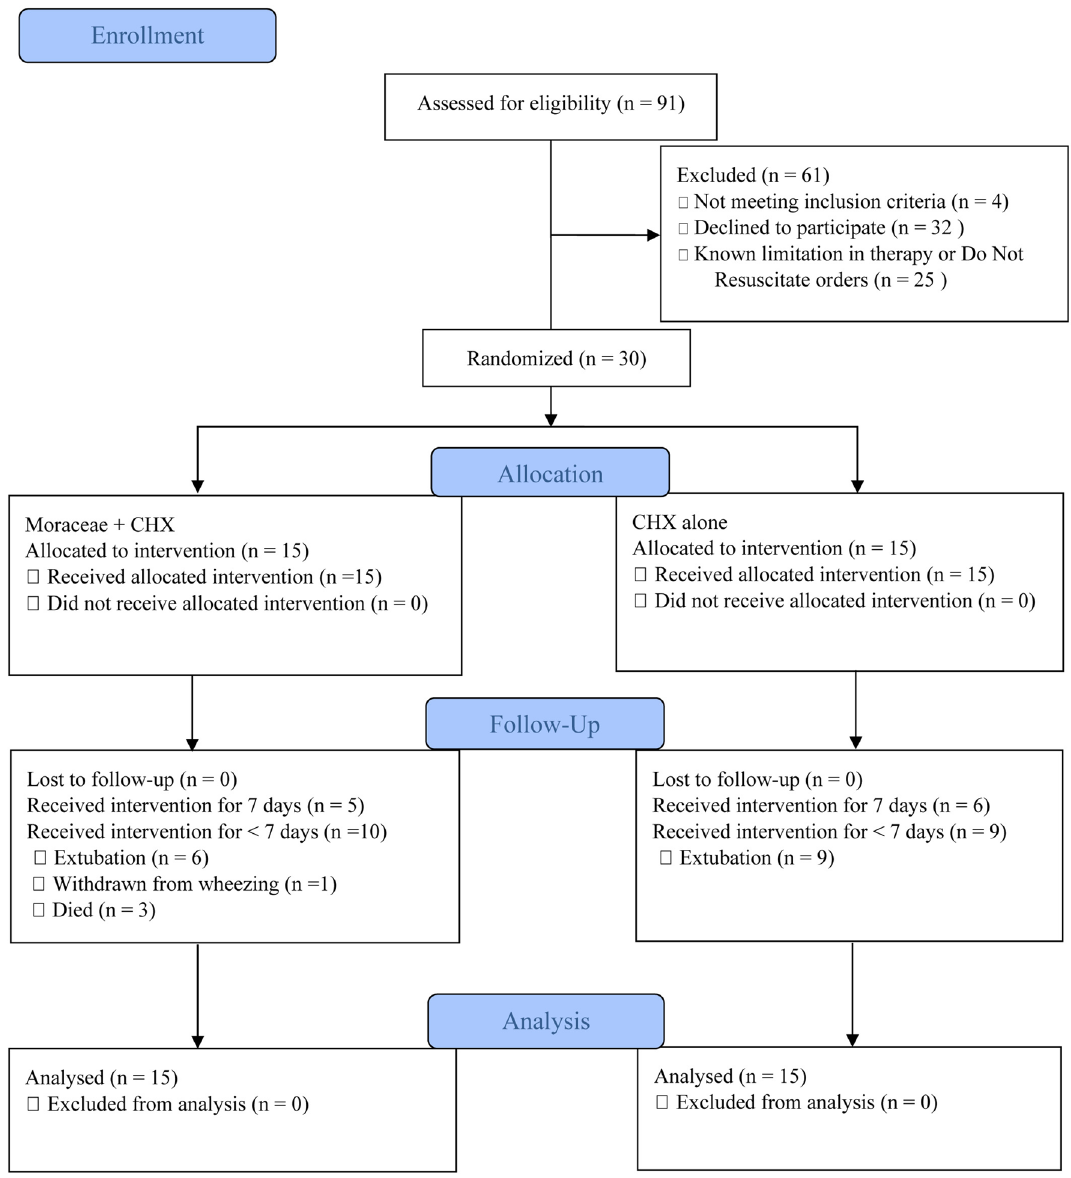
Figure 1. Flow diagram describing the screening, recruitment, and randomization of patients. CHX,